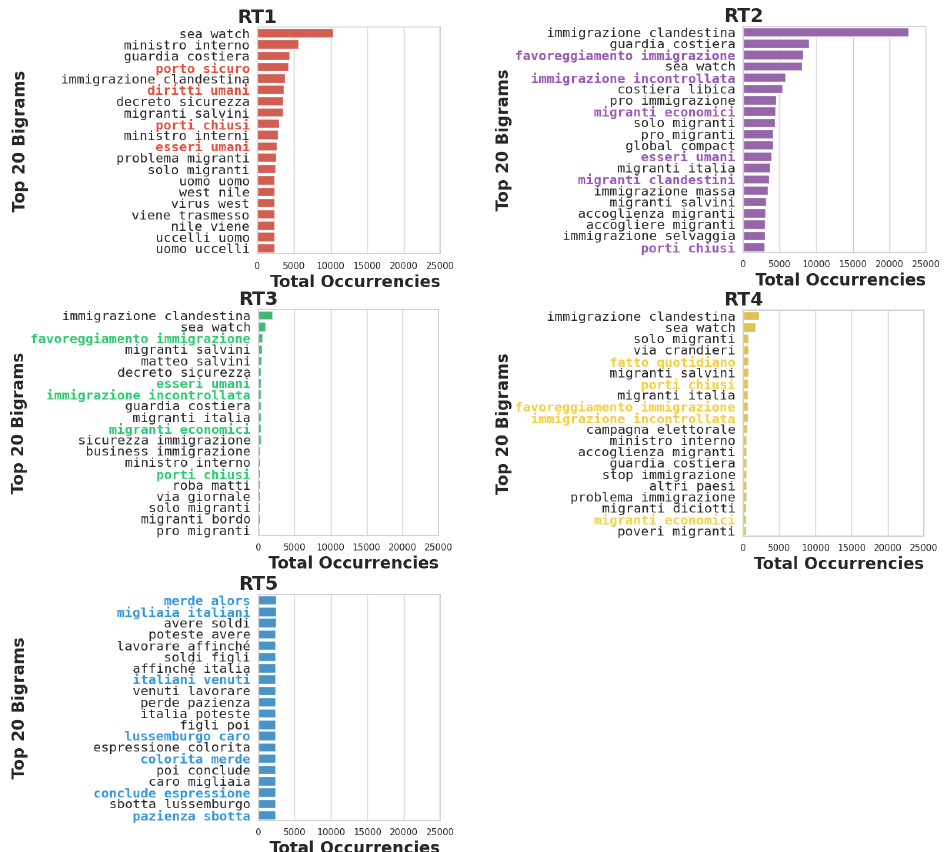
Figure 8. Distribution of the bi-grams among the communities. The common scale for the x-axis highlights the heavy usage of the pair illegal-immigration by RT2 users.